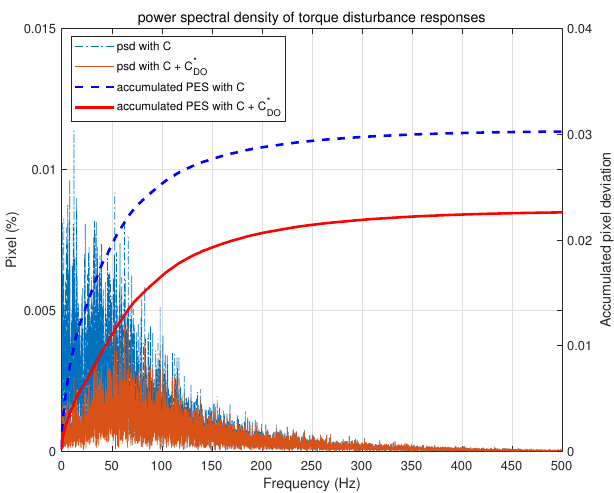
Figure 13. Compared power spectral